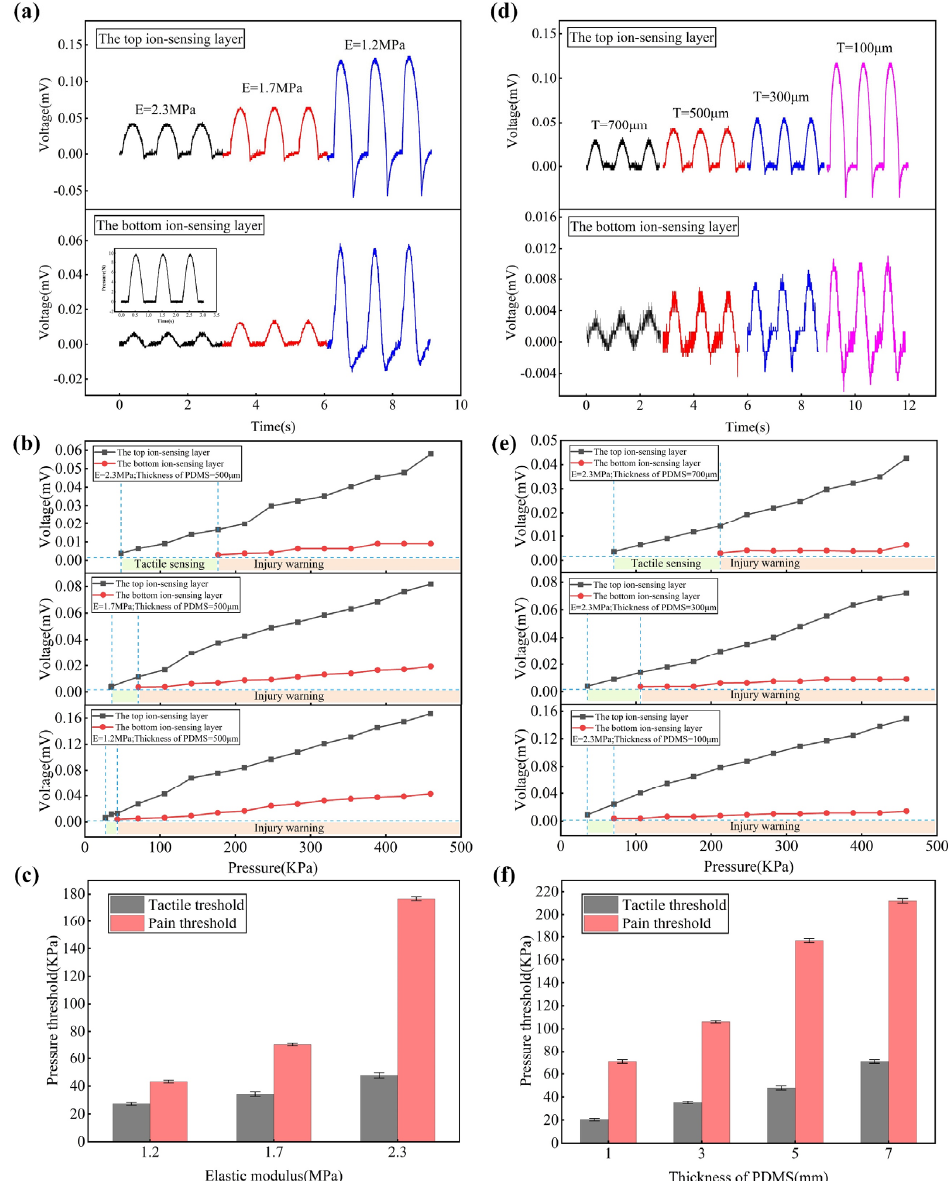
Figure 7. The experimental results. ( a ) Effect of PDMS layer with different elastic modulus on voltage response of artificial receptor. ( b ) The tactile/pain − sensing range of artificial receptors with change of PDMS elastic modulus. ( c ) The induced touch/pain threshold changes with different elastic moduli of PDMS layer. ( d ) Effect of PDMS layer with different thickness on voltage response of artificial receptor. ( e ) The tactile/pain − sensing range of artificial receptors with change of PDMS thickness. ( f ) The induced touch/pain threshold changes with different thicknesses of PDMS